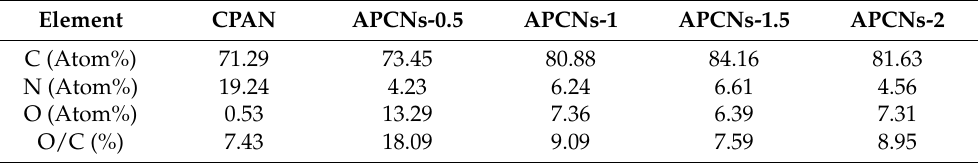
Figure 8. TEM image of APCNs-0.5. Table 3. Elemental analysis of APCNs products with different activation holding